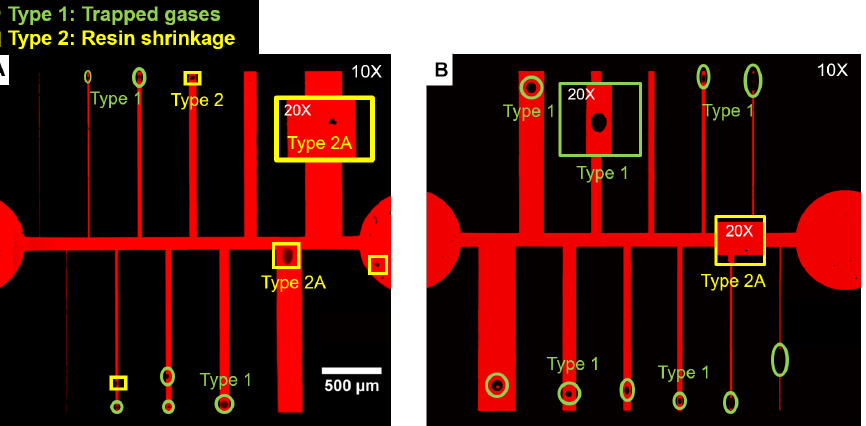
Figure 6. Confocal images of the micromodels impregnated by resin under two vacuum levels: ( A ) 10 mbar, and ( B ) 120 mbar. Type 1 defects, trapped gas, are more abundant in model B due to the inefficient degassing and impregnation energy. Type 2 shrinkage defects are more abundant in model A, because the epoxy resin is more aggressively vaporized. Type 2A refers to void shrinkage defects, while type 2B refers to